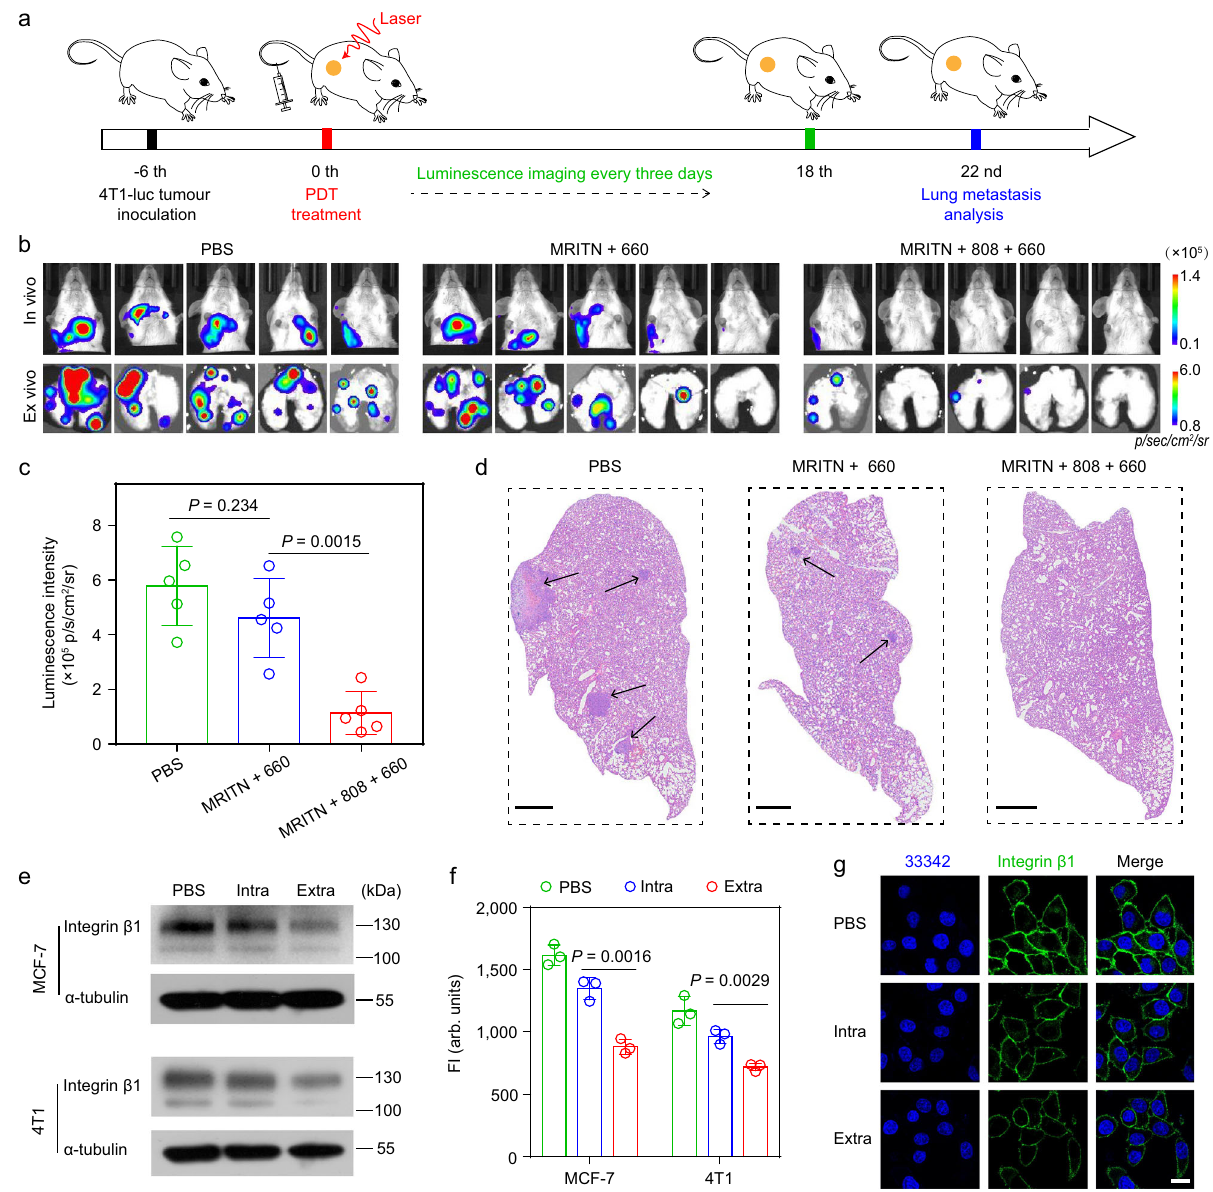
Fig. 6 In vivo anti-metastasis effect by combined extracellular and intracellular PDT in 4T1 tumor-bearing mice. a Therapeutic schedule for combined PDT. b In vivo and ex vivo lung metastasis of each group analyzed by bioluminescence imaging. c The quantitative result of ex vivo lung metastasis in Fig. 6b. Data were presented as mean ± s.d. ( n = 5 biologically independent mice). Statistical analysis by two-sided Student t-test. d H&E staining of the lungs at the end of antitumour study. The areas pointed by the arrow were tumor metastasis nodules. Scale bar = 1 mm. e – g The downregulation of integrin β 1 by intracellular PDT or extracellular PDT measured by e western blot, f fl ow cytometry ( n = 3 biologically independent cell samples, two-sided Student t -test), and g confocal microscope. The tumor cells treated with intracellular PDT or extracellular PDT were washed with PBS and then lysed with RIPA lysis buffer for western blot analysis. The treated cells were stained with integrin β 1 antibody followed by AF594-conjugated secondary antibody, then analyzed by fl ow cytometry and confocal microscope, respectively. Scale bar = 20 μ m. All data were presented as mean ±